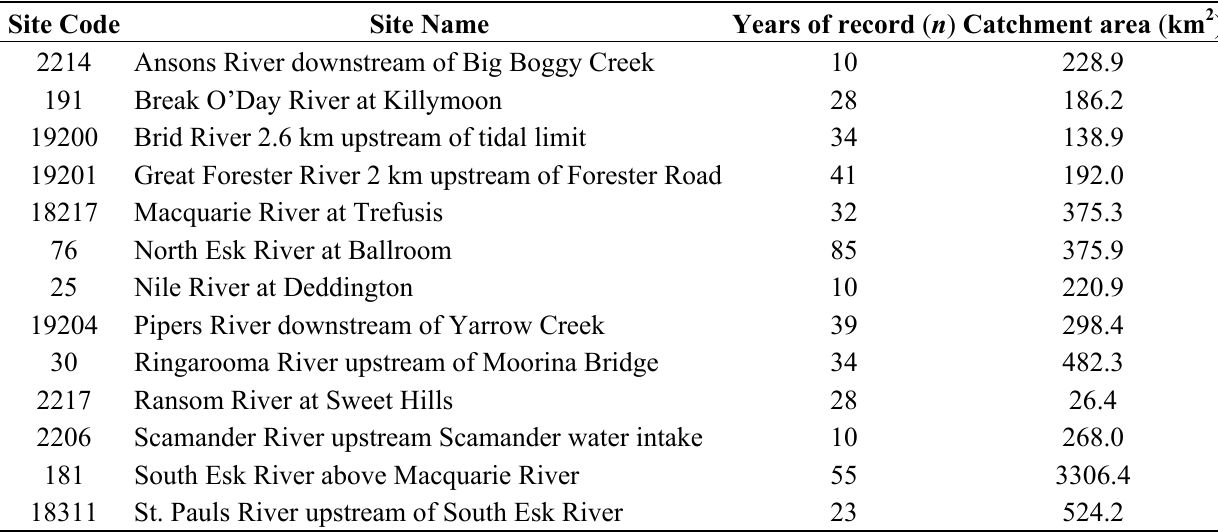
Table 1. Stream gauging sites and flow records used in the flood frequency